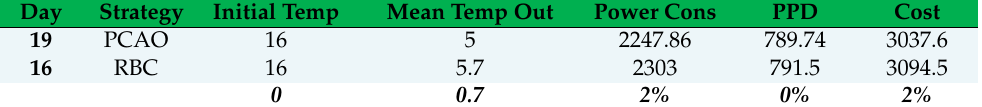
Table 11. Comparison between the PCAO (19th) and RBC (16th) winter days.